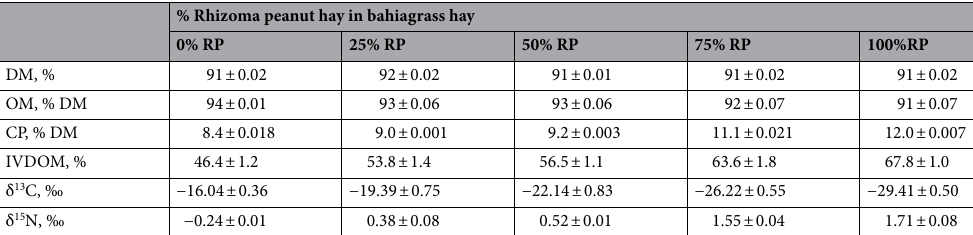
Table 1. Chemical composition of the five treatment diets offered to beef steers, each with increasing proportion of rhizoma peanut (RP) hay into bahiagrass hay. Means indicate average of 10 samples ± standard deviation. IVDOM in vitro digestible organic matter, estimated utilizing the two-stage technique described by Moore and Mott 41